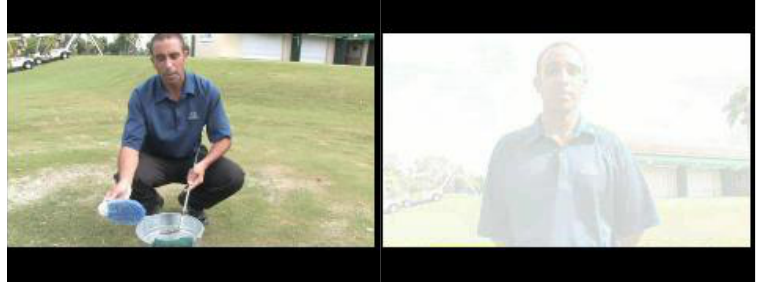
Figure 4. (left) Good training sample, (right) Bad training